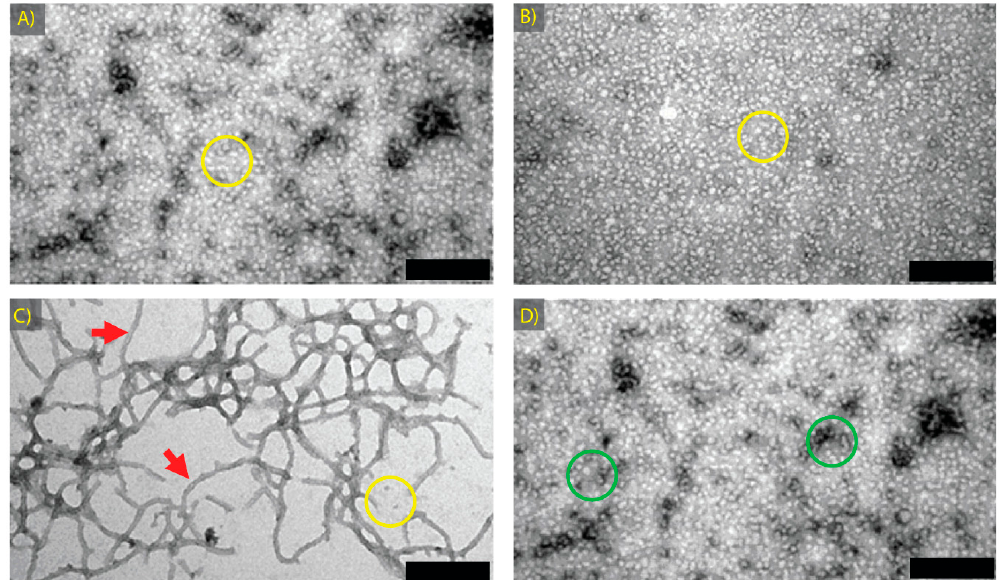
Figure 4. TEM images of α B ‐ crystallin species formed to assess the effects of structural variation on chaperone activity: ( A ) α B Native; ( B ) α B GdnHCl Native; ( C ) α B Fibril; and ( D ) α B Amorphous. All samples were prepared as described in Table 1. Scale bars are 200 nm. Features of importance are highlighted, including long amyloid fibrils (red arrows) and spherical aggregates of ~15 nm in diameter (yellow circles) or larger spherical aggregates (green circles).